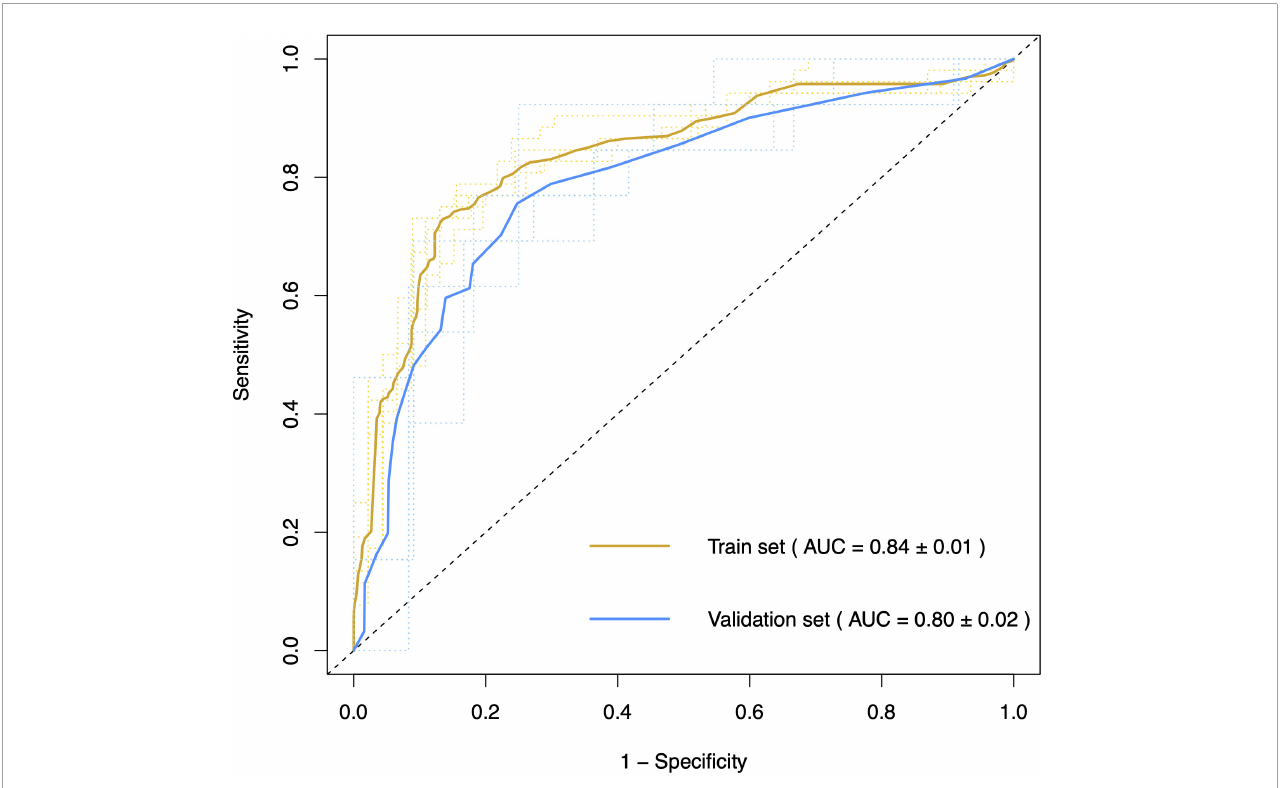
FIGURE6 Area under curve of support vector machine model for differentiating patients with and without ALS. The 5-fold cross-validation support vector machine model classified patients with ALS and non-ALS participants in the test cohort with an accuracy of 78.67% (AUC =